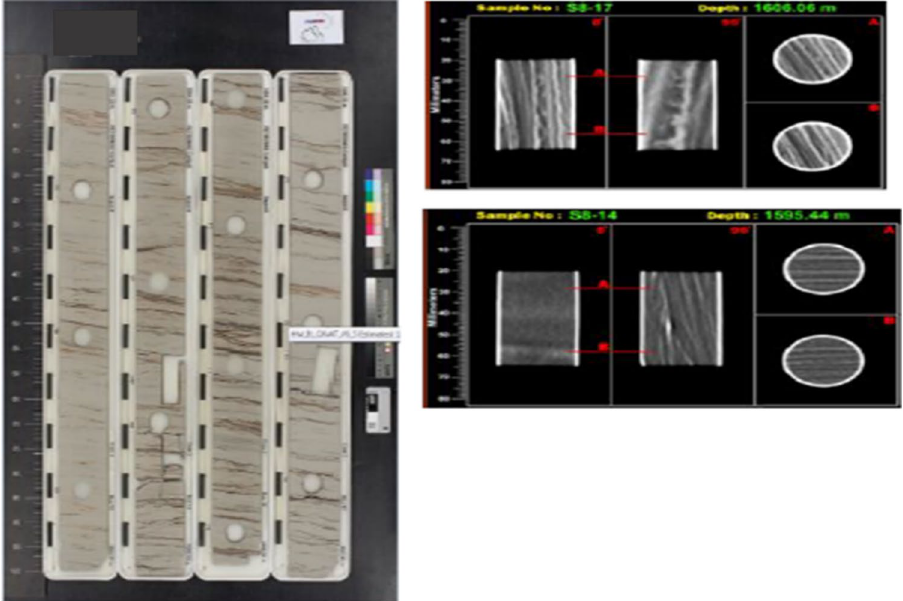
Fig. 1 Example of thinly lami- nated sand observed on core slab (left) and CT images of core plugs